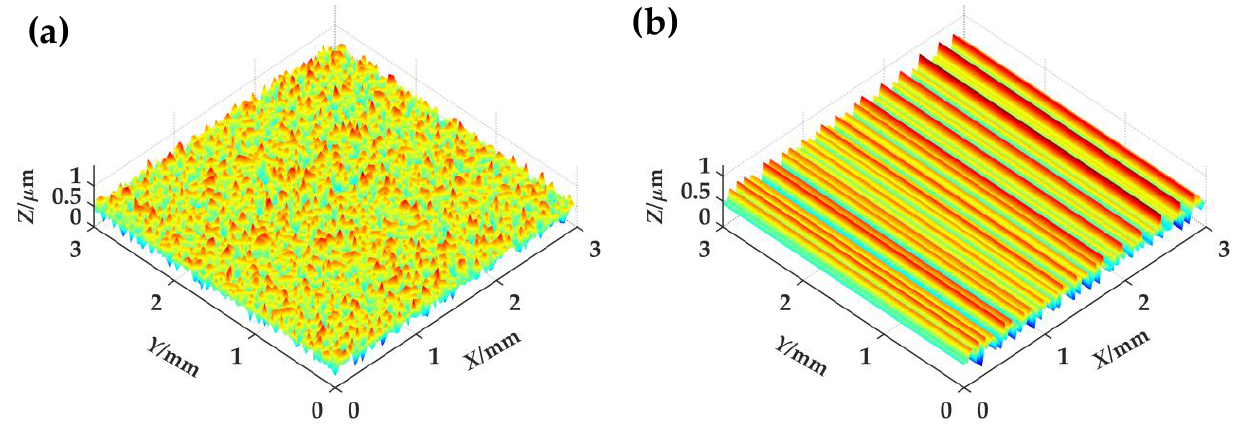
Figure 3. The 3D fractal surfaces under D = 2.4, G = 1 × 10 − 13 : ( a ) Isotropic surface; ( b ) anisotropic surface.